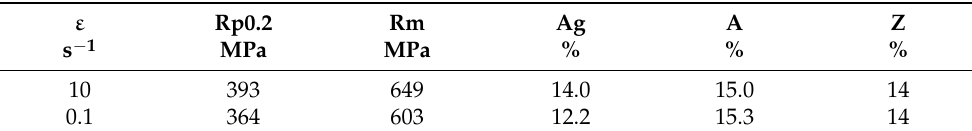
Table 2. Tensile tests results at room temperature. Hot-rolled sheets after solution treatment (1100 ◦ C/30 min./cooling in still air.).